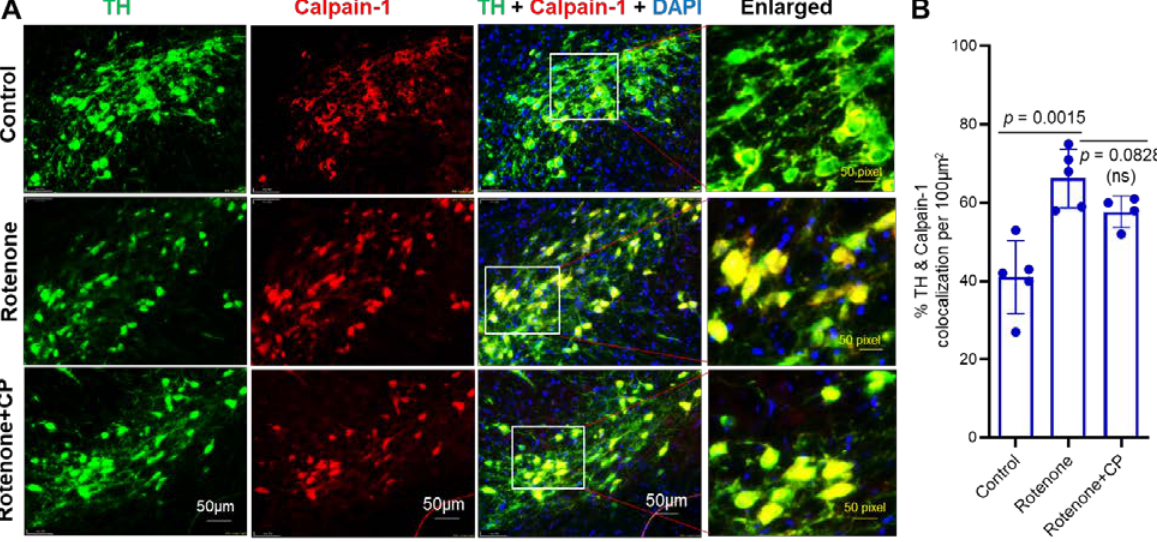
Figure 3. Calpain-1 expression was upregulated in SN DA neurons following rotenone administration, and it was retained after CP treatment. ( A ) Representative images from the respective treatment groups showed that TH-immunostained SN DA neurons co-localized with calpain-1 (arrows). Calpain-1 staining (red) indicates cytoplasmic localization in the SN neurons stained with TH (green). Merged images showed co-localization (yellow) of TH+ calpain-1 with a distinctly DAPI counter-stained nucleus (blue/purple color) after CP treatment. N = 3. ( B ) Quantitative analysis of TH+ and calpain-1+ cells colocalized per 100 µm 2 following CP treatment. N = 4–5.